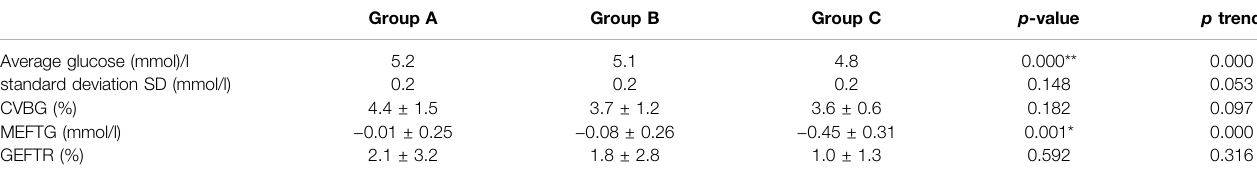
TABLE 4 | Indexes of the quality assessment of euglycemic clamp in three groups. Group A Group